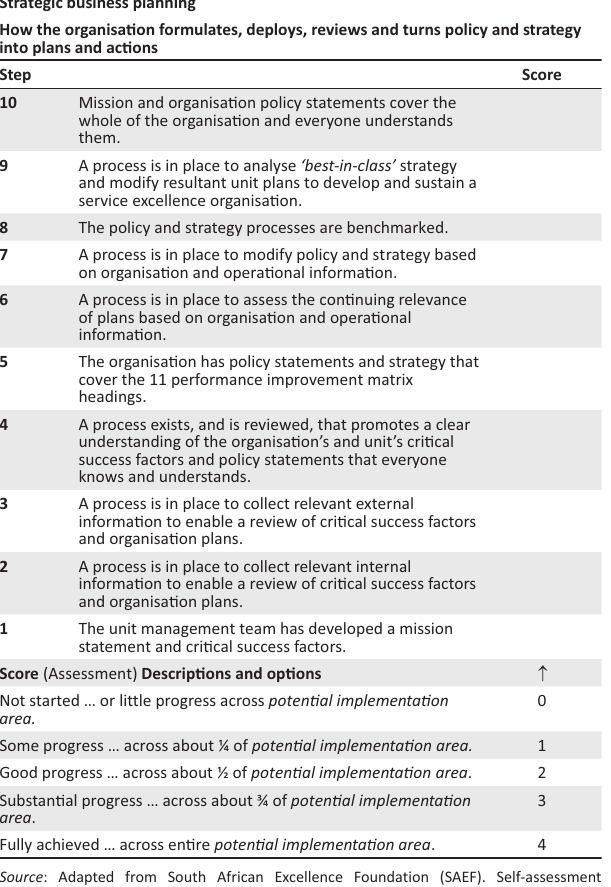
FIGURE 2: The South African Excellence Model matrix chart used to assess the performance of the agricultural small-, micro- and medium-sized enterprises relevant to the strategic business planning function.